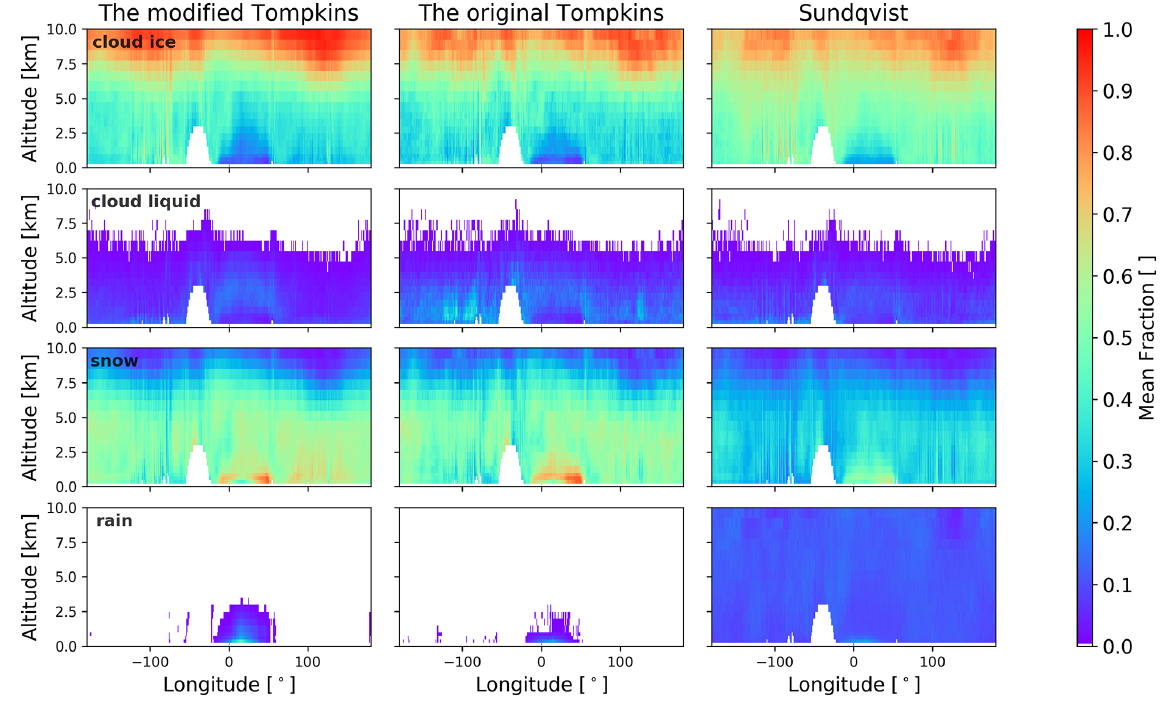
Figure A10. A mean fraction of reflectivity contributed by the different hydrometeors as a function of altitude for a latitude band of 72– 73 ◦ N in winter (DJF) for the different microphysical schemes, the modified Tompkins (left panel), original Tompkins (middle panel), and Sundqvist (right panel) schemes, respectively.